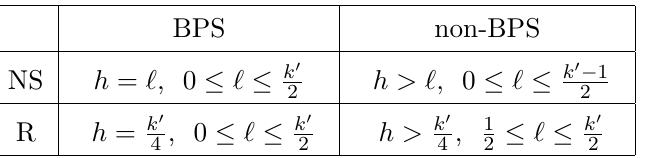
Table 1 . = 4 superconformal primaries in BPS and non-BPS N